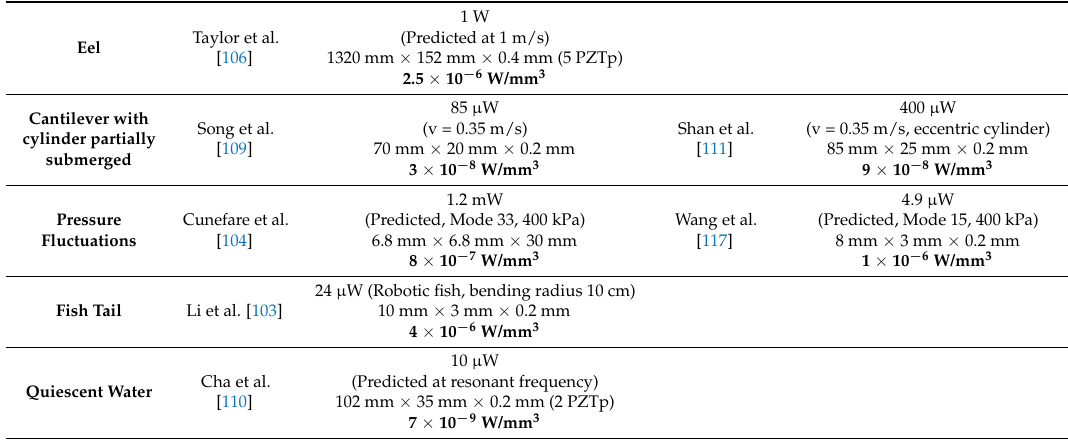
Table 1. Approximated power, approximated size of the PZTp and power density (W/mm 3 ) based on the different working